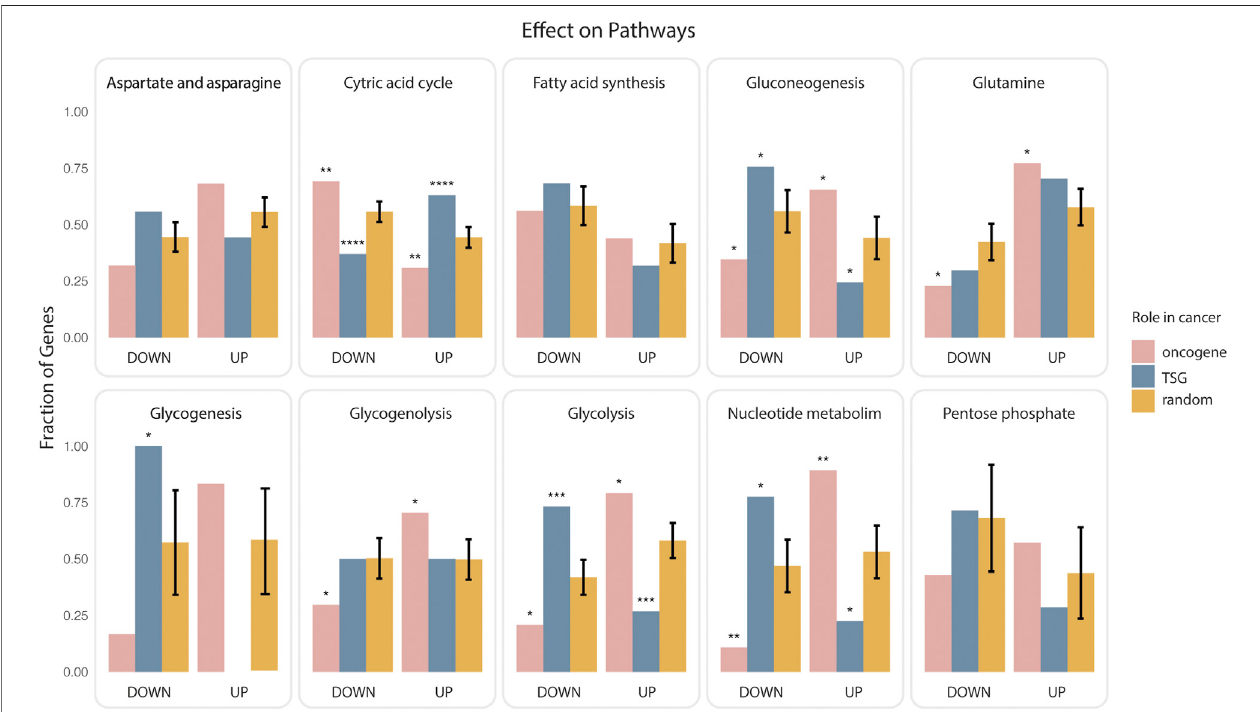
FIGURE 2 | Impact of cancer genes on metabolism. Oncogenes or onco-suppressors (TSG) that were found to be signi fi cantly closer to ten metabolic pathways were classi fi ed as activators or inhibitors depending on whether the paths of causal interactions that permit joining the gene and the rate limiting enzymes contained an evenoroddnumberofinhibitorysteps.Thefractionofactivating(UP)orinhibiting(DOWN)pathsforeachgenegroup(oncogenesinpink,onco-suppressorsinblue),and each pathway was plotted as bar graphs enclosed in rectangular frames. The bars in orange represent the average of an equivalent fraction in 1000 different random collections of 700 genes. Signi fi cance of the observed differences was evaluated by a two-sided t-test ( p value: * < 0.025, ** < 0.0025, *** < 0.00025, **** <